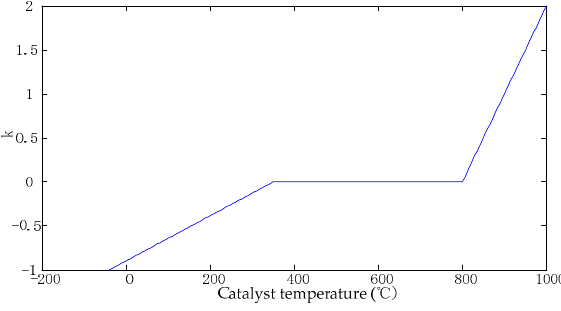
Figure 11. The value of the weighting factor.